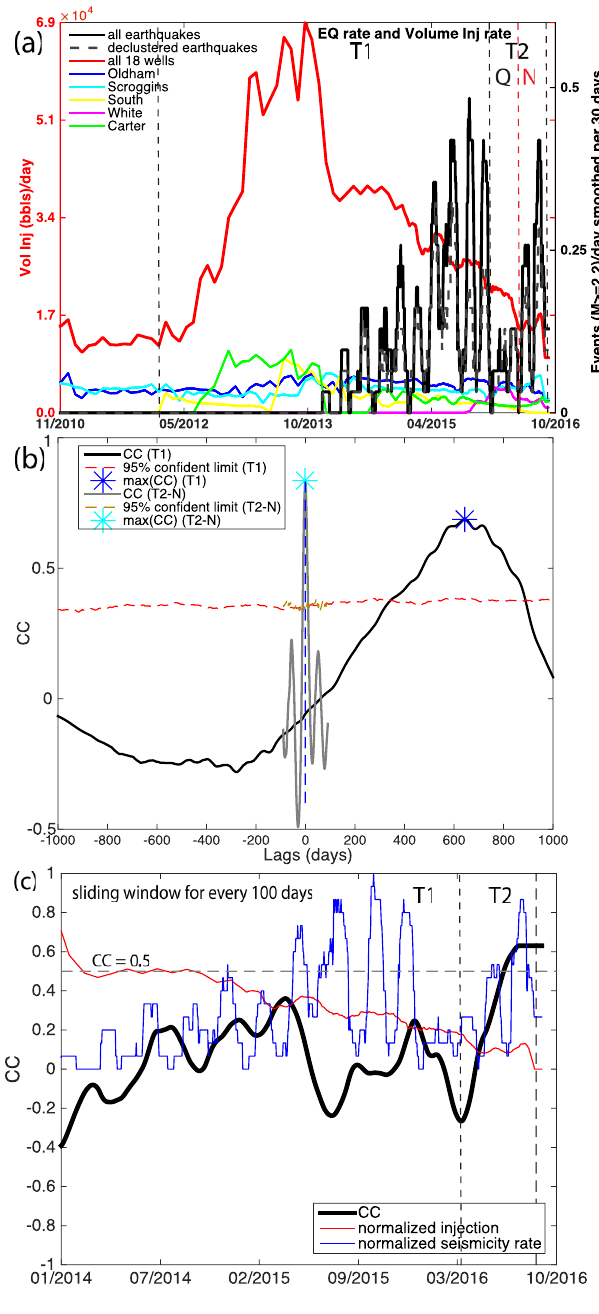
Figure 6. Relationship between injection and seismicity in the Pawnee area. ( a ) Black line: daily earthquake rate for M ≥ 2.2 events, smoothed for 30 days. Colored lines: daily injection volume for all 18 wells in Fig. 4 combined (red) and selected individual wells. Zoomed-in view of T2 is shown in Figure S8. ( b ) The cross- correlation between injection rate and seismicity for T1 (black solid line, with blue dashed line showing the maximum correlation), and for T2-N (grey solid line, with cyan dashed line showing the maximum correlation), the red and brown dashed lines show the 95% confidence limit. ( c ) Sliding time window correlation between smoothed injection and seismicity rate (thick black lines). The normalized injection and seismicity rates are shown as thin red and blue lines for reference. The dashed line denotes “cc = 0.5” to show periods with high correlation, which is only observed in period “T2”. This uses the relocated